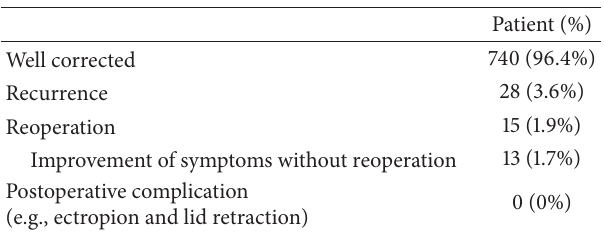
Table 4: Postoperative